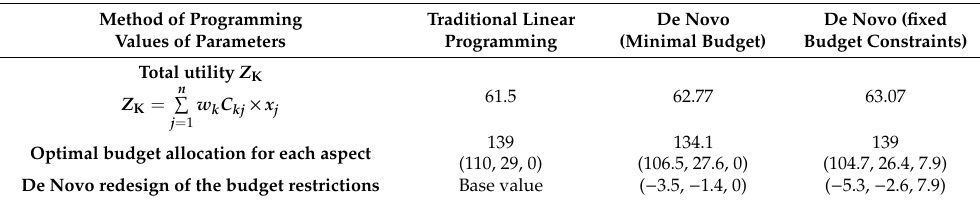
Table 9. Comparison of analysis